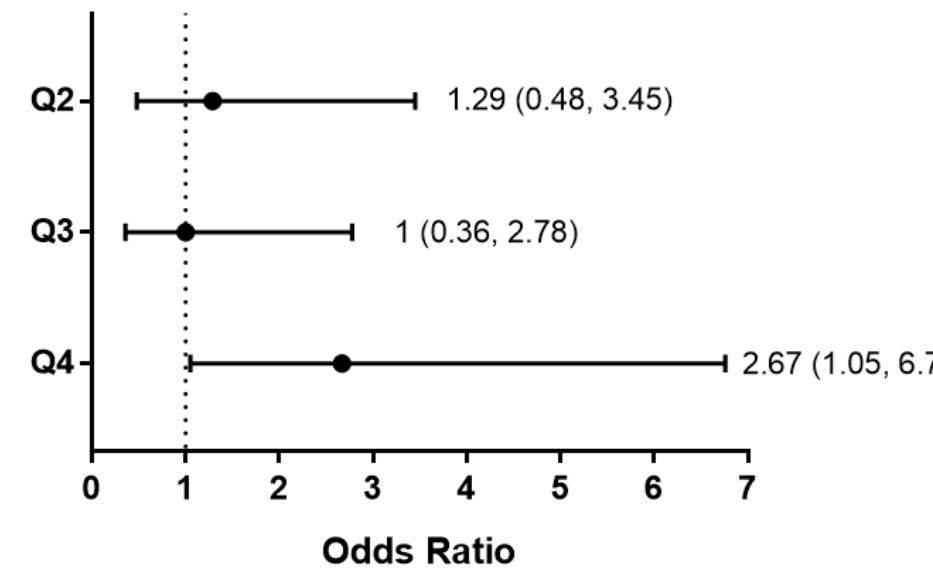
Figure 21. Forest Plot of End Point Analysis. The odds ratio (OR) with 95 percent confidence intervals for reaching the end point in the second, third, and fourth quartiles of baseline FSTL1 mRNA levels. The first quartile was the reference group. The OR was not adjusted for baseline clinical variables.